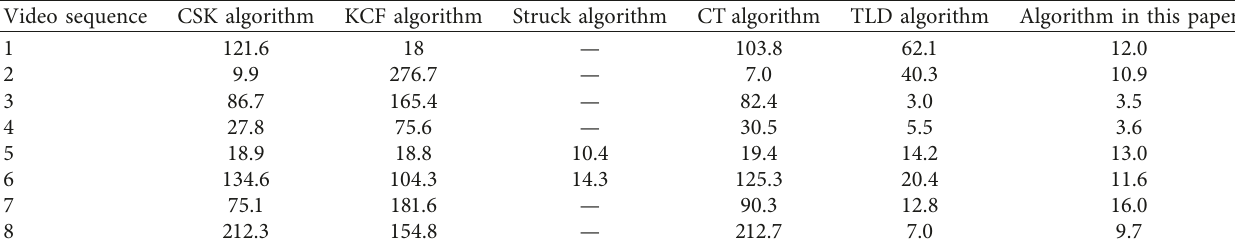
Table 3: Average center position deviation of different algorithms (pixel).